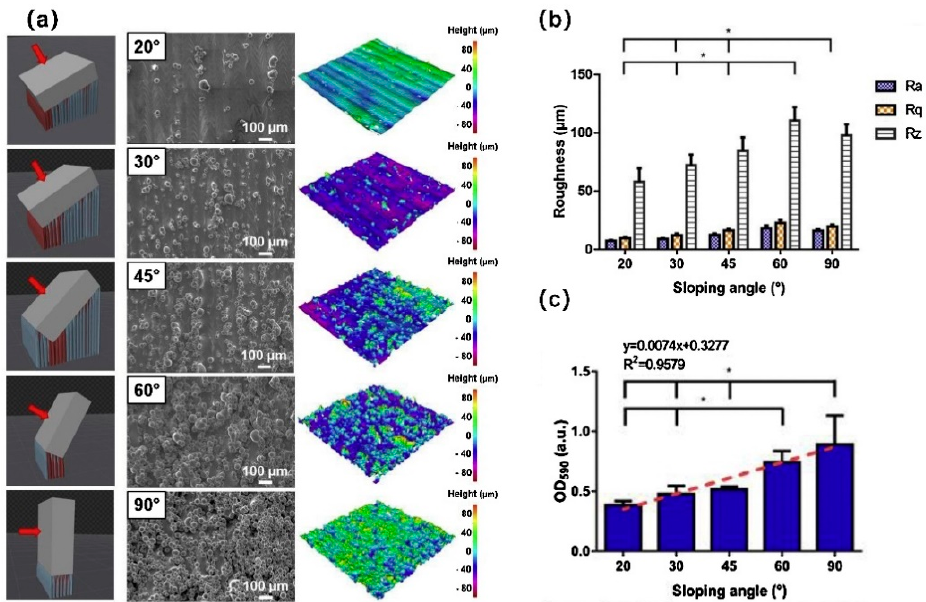
Figure 2. The SLM build inclination angle affects the surface roughness, which in turn affects bacterial adhesion. ( a ) Three- dimensional model of the build inclination angle, SEM micrograph images, and topographic scan of as-built Ti6Al4V samples with sloping angles from 20° to 90°; ( b ) measured arithmetic mean height ( R a ), root mean squared height ( R q ), and maximum height of profile ( R z ) as average values of 20 scans, where * signifies p -value < 0.05 for R a . ( c ) After 24 h of colonization, the biomass of S. epidermidis was quantified using crystal violet staining. Reprinted with permission from ref. [62]. Copyright 2020 Elsevier.